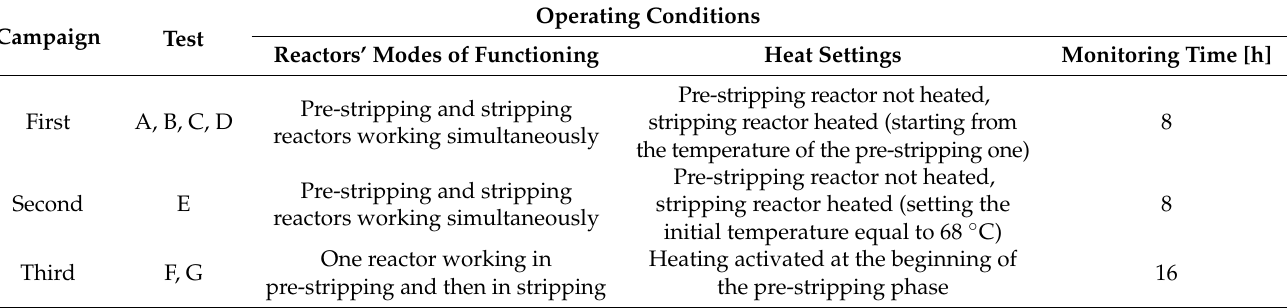
Table 2. Summary of campaigns and tests carried out and their operating